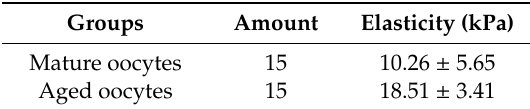
Table 3. Comparison between mature oocytes and aged